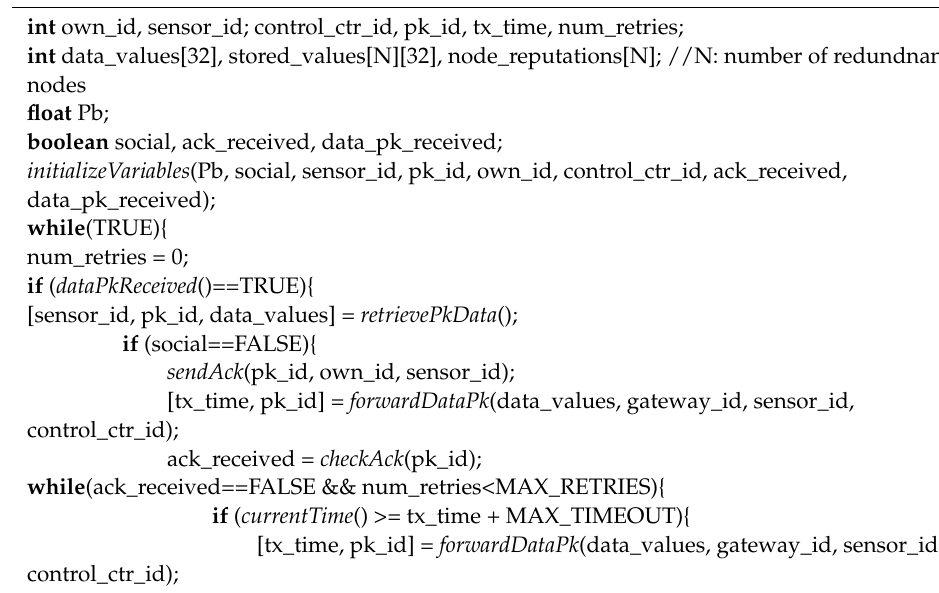
Algorithm A2: Gateway Node Application